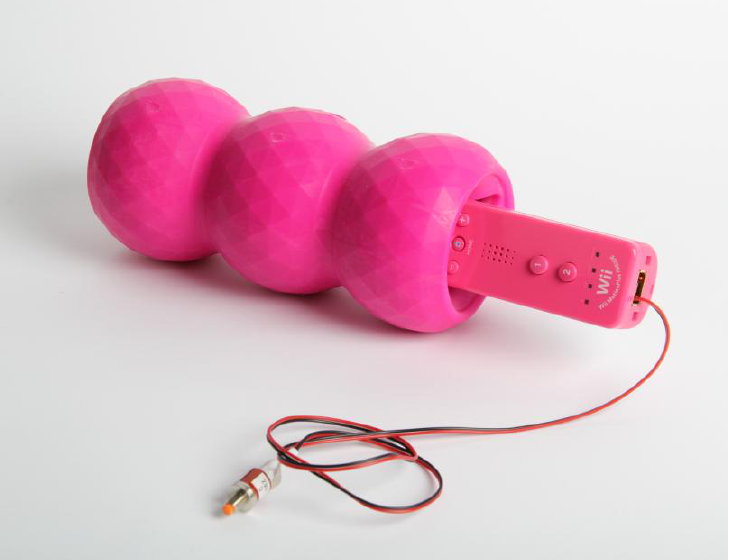
Figure 6. The wireless prototype. The cable, connecting our external custom synchronization button to the Wii Remote, can be hidden inside the Kong toy once the synchronization is